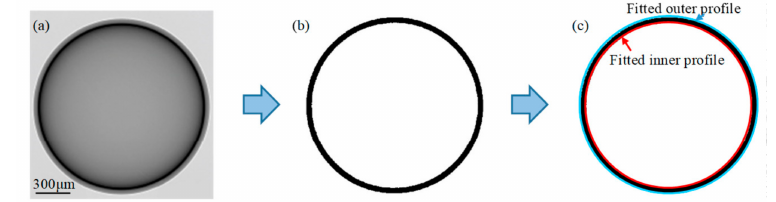
Figure 5. Schematic of the measurement of the wall thickness and the sphericity of the PS microsphere by X-ray in one direction: ( a ) original X-ray image, ( b ) binary image, and ( c ) fitted inner and outer profiles of ( b